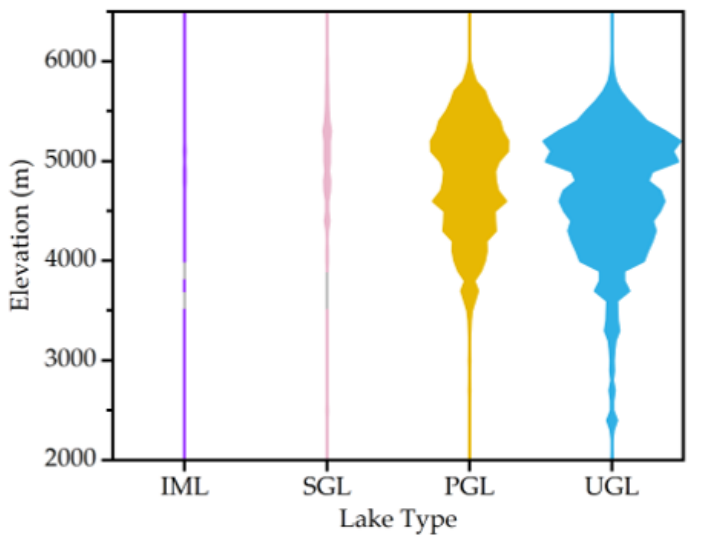
Figure 7. Altitudinal characteristics of various types of glacial lake areas in 2013 – 2019. The width of the colored pattern in the figure represents the area of different types of glacial lakes at different altitudes. The wider the pattern, the larger the area.